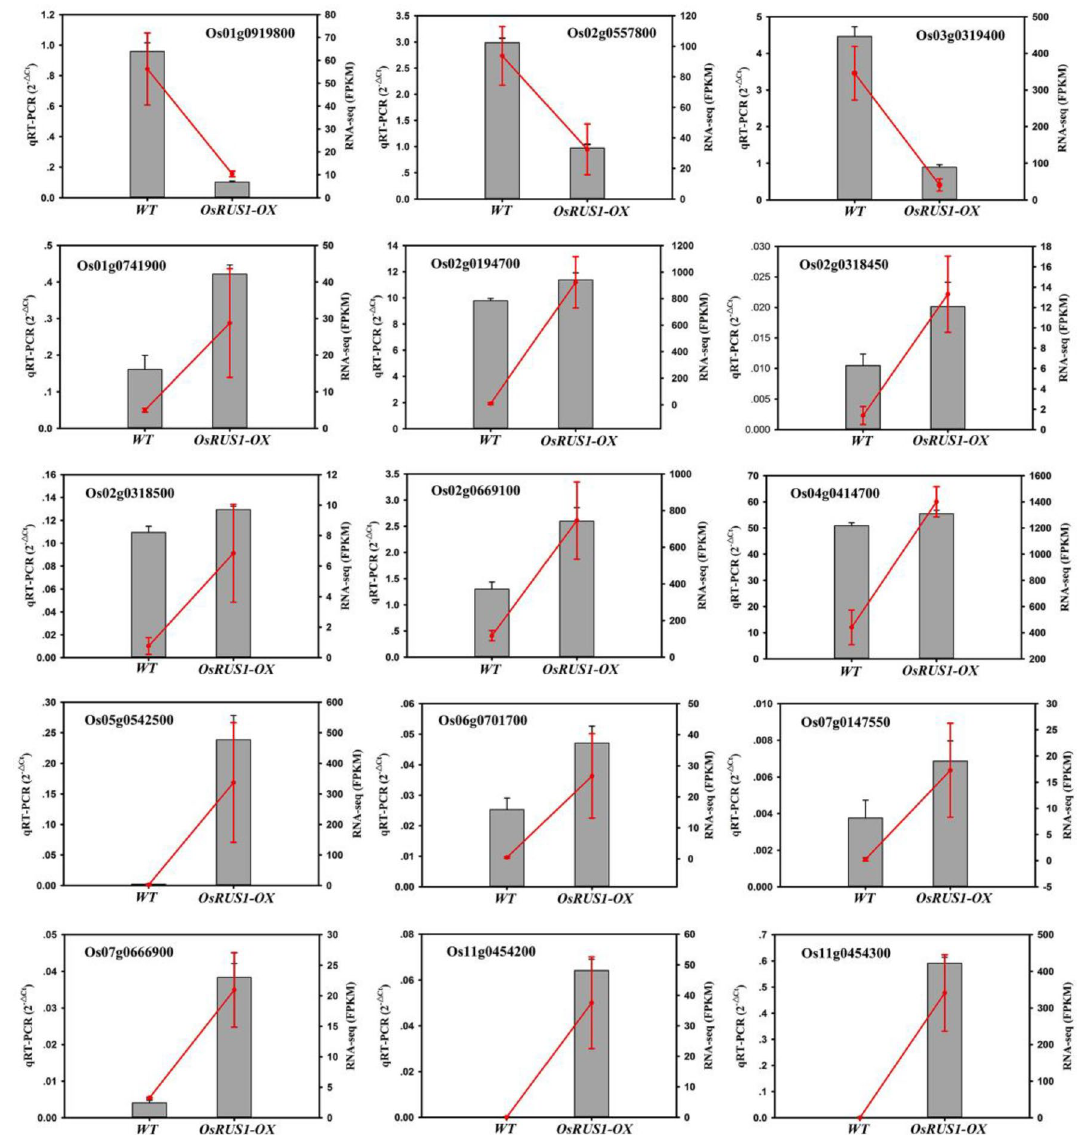
Figure 7. Verification of differentially expressed genes between WT and OsRUS1-OX by qRT-PCR. Note: Histograms represent the results of the qRT-PCR assays, using the 2 −ΔCt algorithm, with the scale on the left ordinate of each graph. Red dots represent the results of the FPKM analyses, with the scale on the right ordinate of each graph. WT, the wildtype of ZhongHua11; OsRUS1-OX , the OsRUS1-GFP Overexpression transgenic